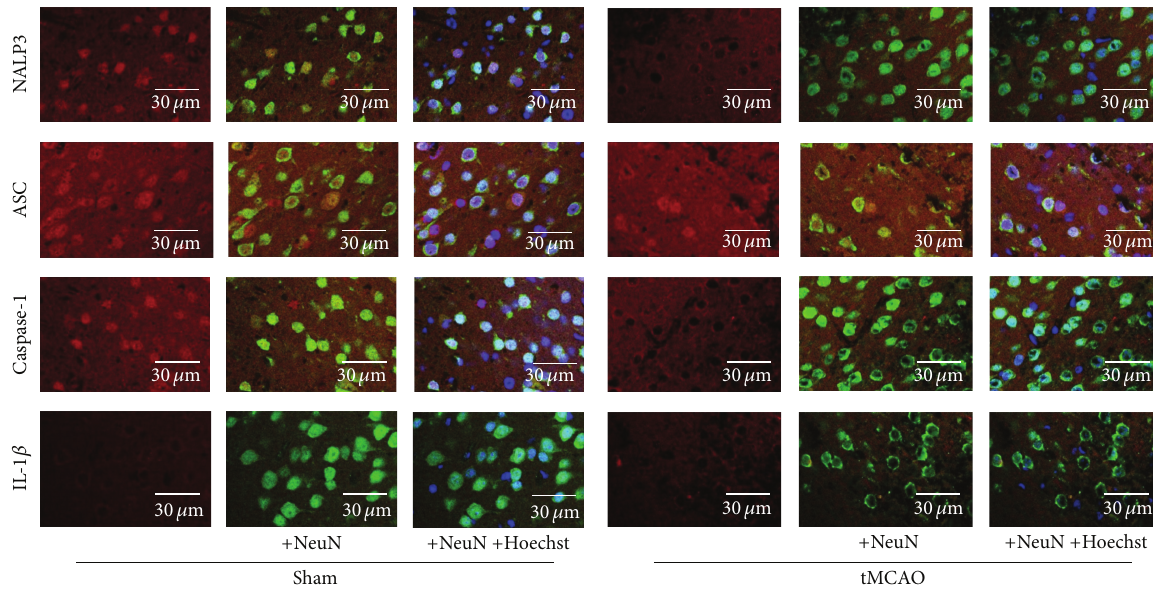
Figure 3: Cellular distribution of NALP3 inflammasome components and IL-1 𝛽 in the ischemic penumbra zone of cerebral cortex. Sections were triple-stained for NALP3, ASC, caspase-1 and IL-1 𝛽 (red), NeuN (green), and nucleus (blue). In tMCAO group, the neuronal karyopyknosis and chromatin margination could be observed and there was a small amount of neutrophils in marginal zone of infarction. In the normal brain (Sham), caspase-1 and NALP3 were mainly present in the nucleus of neurons whereas IL-1 𝛽 was mainly localized in the cytoplasm. ASC was present in both the nucleus and cytoplasm. After tMCAO, NALP3 and caspase-1 were redistributed predominantly to the cytoplasm, while ASC and IL-1 𝛽 location remained unchanged.